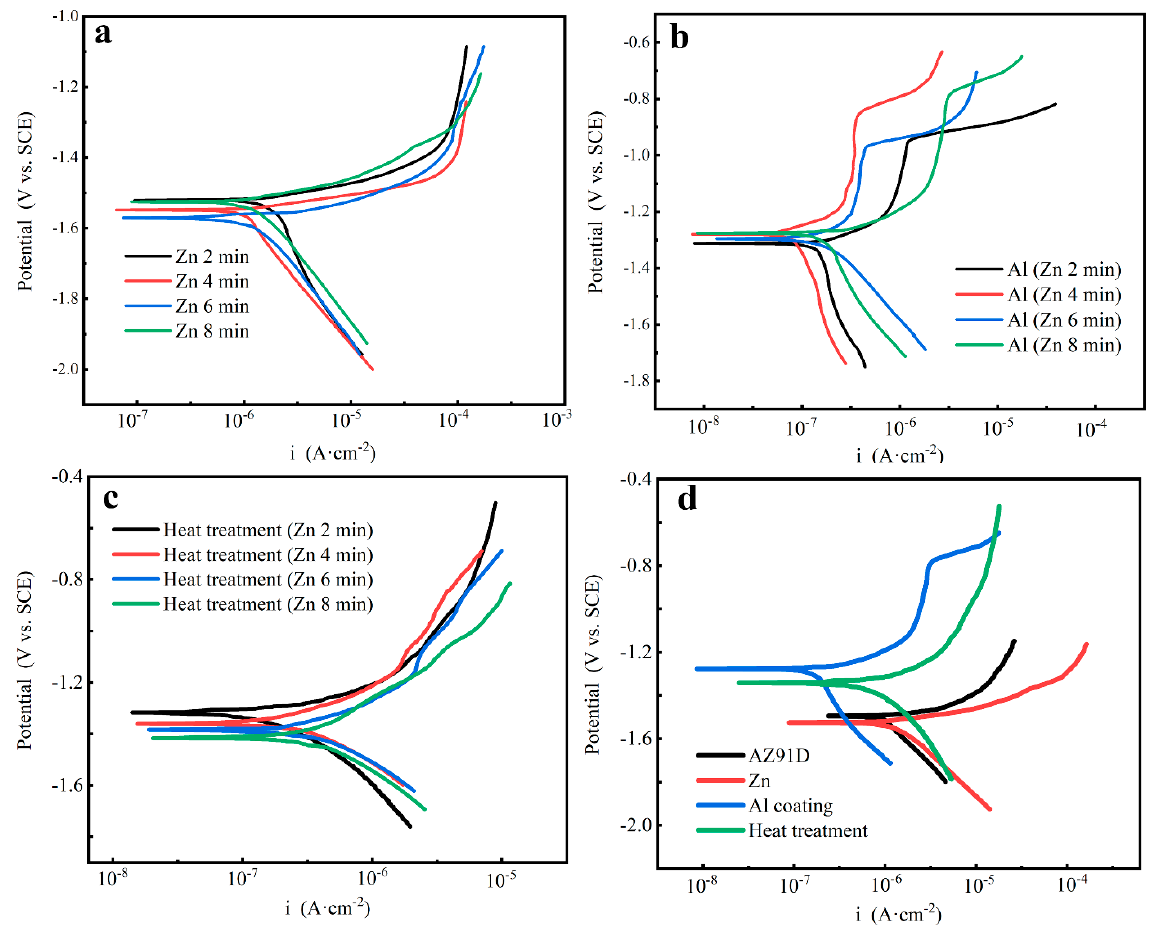
Figure 11. Potentiodynamic polarization curves of ( a ) the Zn layers, ( b ) the Al coatings, ( c ) the Al coatings after heat treatment, and ( d ) the comparison of the curves of the AZ91D substrate, the Zn-immersed, Al-coated, and the heat-treated samples. Table 4. Corrosion characteristics obtained by polarization in 3.5% NaCl solution of the AZ91D, the Zn layers, the Al coatings, and the Al coatings after heat treatment.